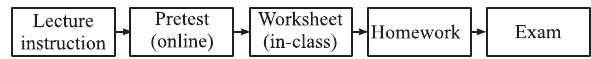
FIG. 1. Timeline of instruction associated with each tutorial